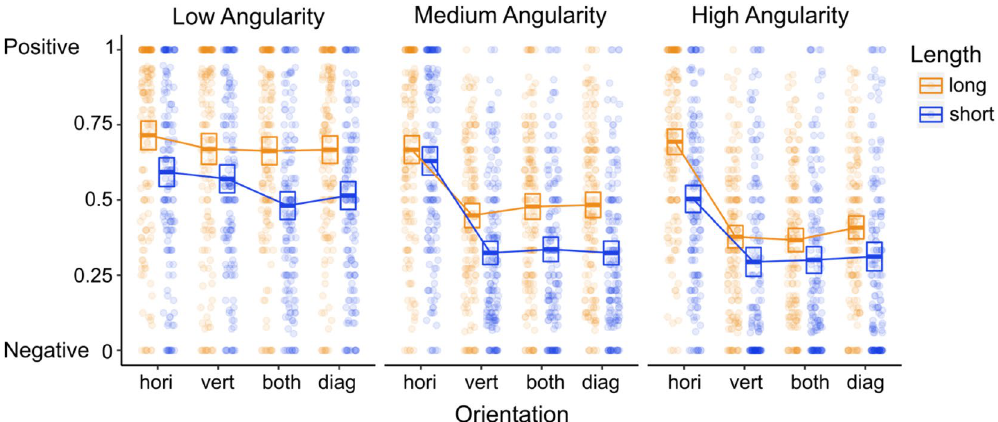
Figure 4. Average positive and negative scores as a function of image contour features. The boxes represent the 95% confidence intervals. The dots represent individual ( N = 157) average values per